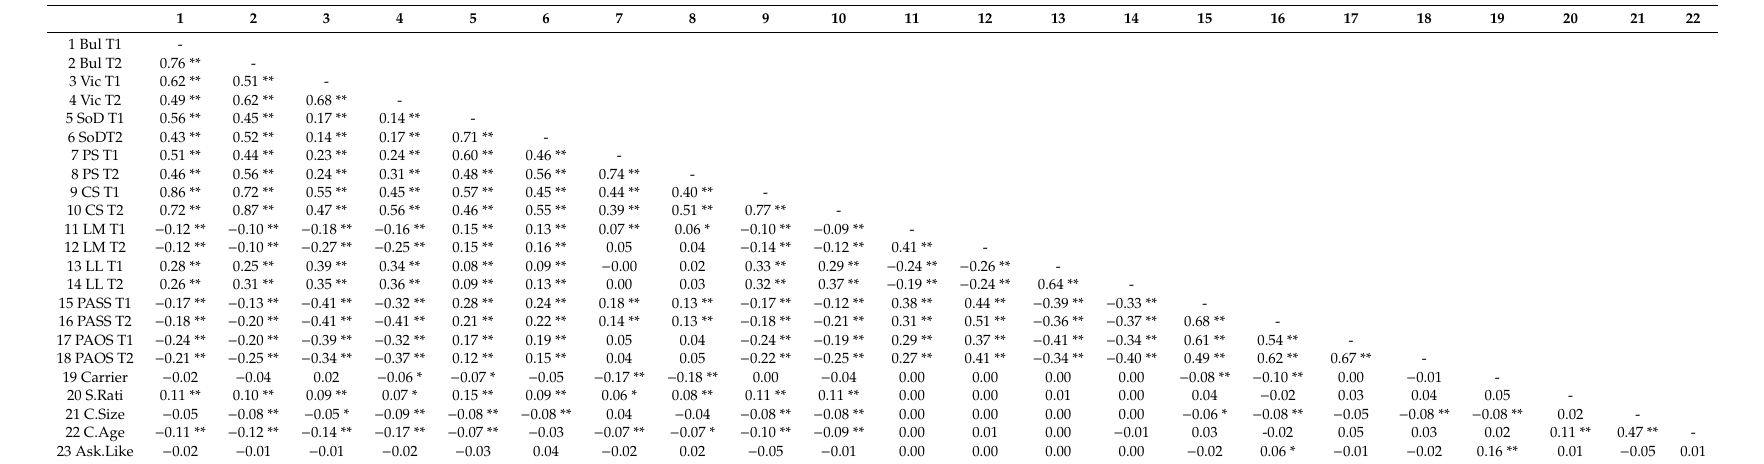
Table 2. Correlations among